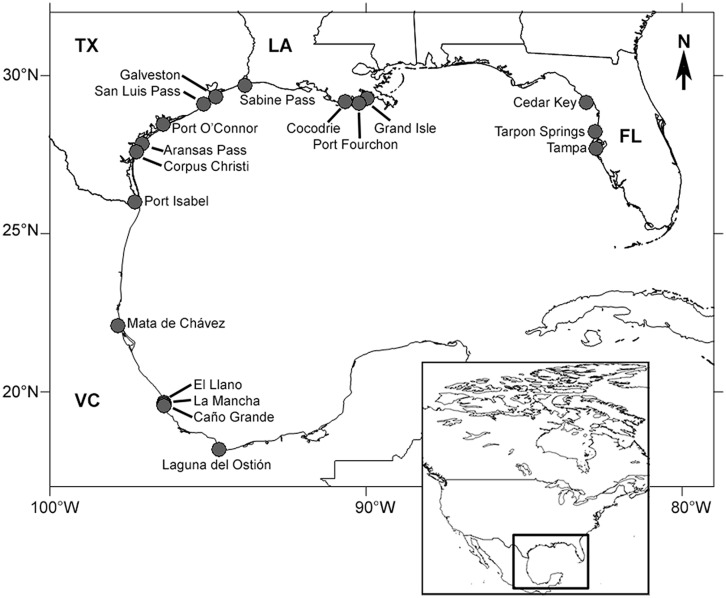
Mangrove collection sites in the Gulf of Mexico. Sites were located in Florida (FL, USA), Louisiana (LA, USA), Texas (TX, USA), and Veracruz (VC, Mexico).